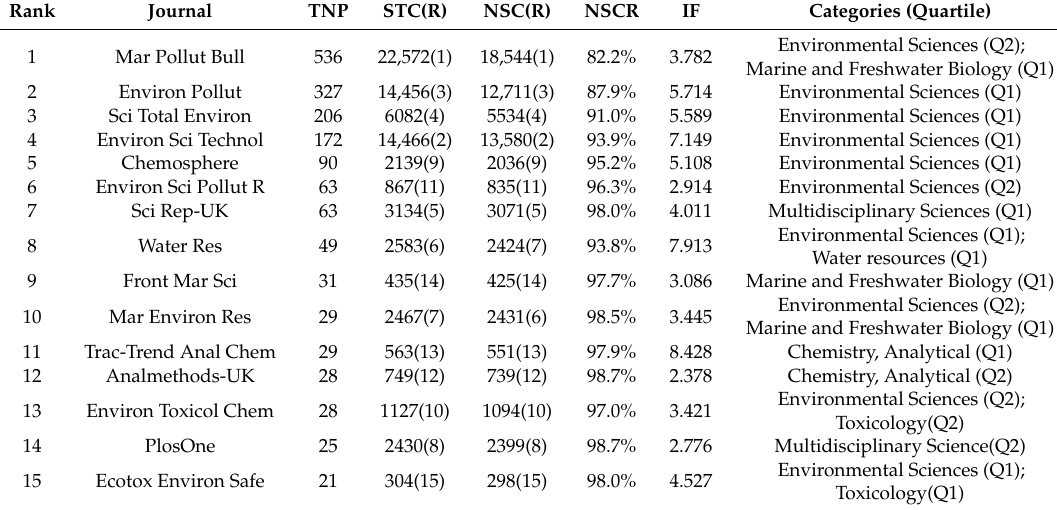
Table 3. The top 15 productive journals that published articles about the MPs